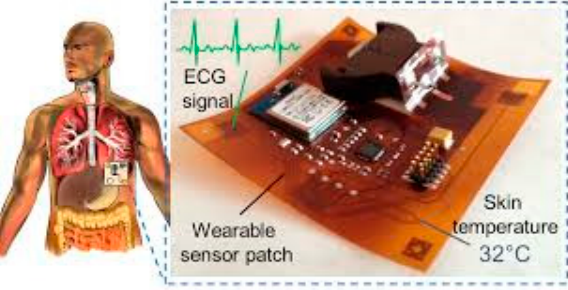
Figure 1. Ultra-thin flexible patch array for physical monitoring.